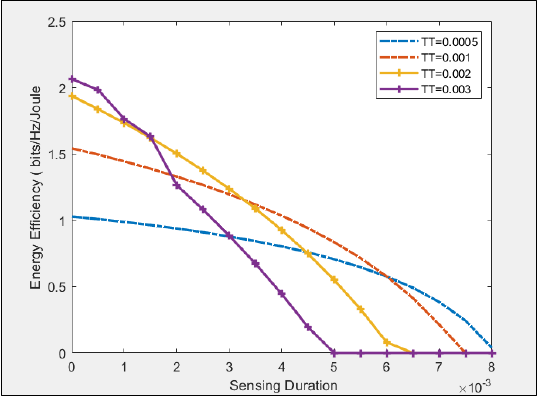
Figure 8. Energy efficiency vs. sensing duration.